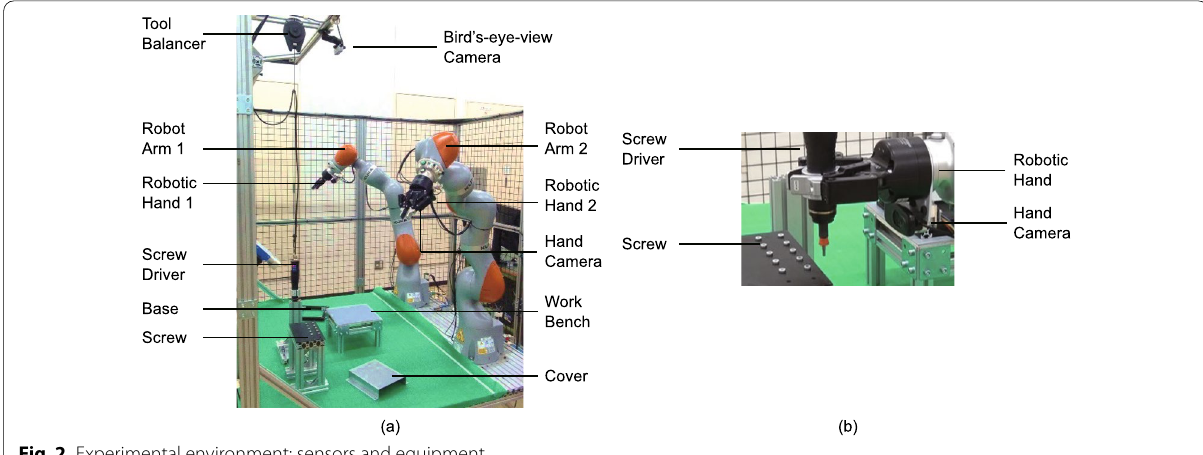
Fig. 2 Experimental environment: sensors and